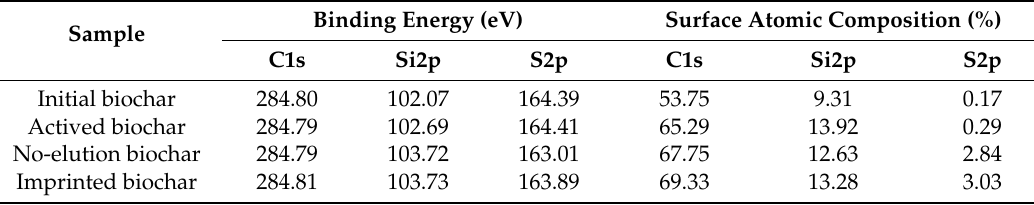
Table 1. Binding energies and relative contents of elements on biochar